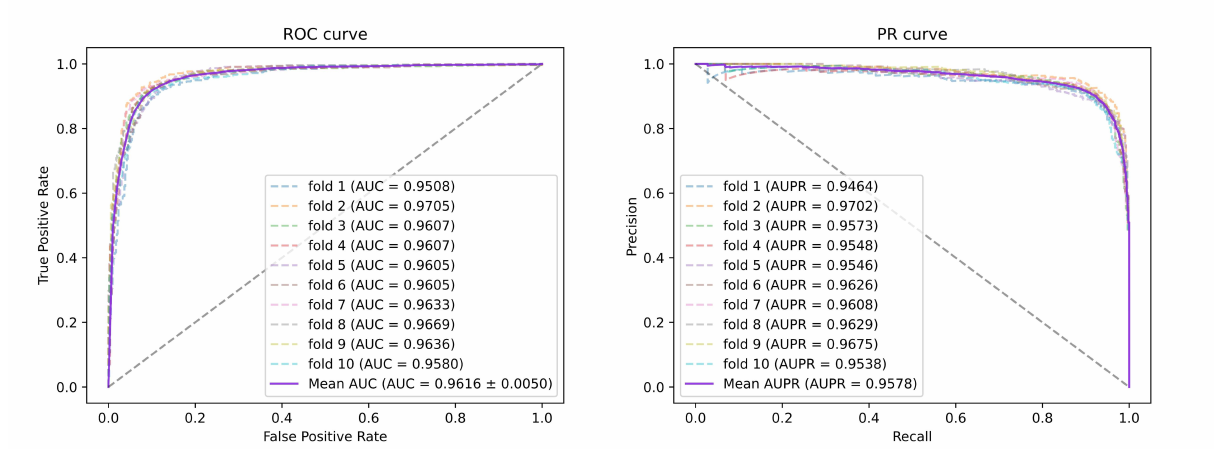
Figure 3. The 10-fold cross-validated ROC curve and PR curve of SGAEMDA model with 96.16% AUC and 95.78% AUPR.